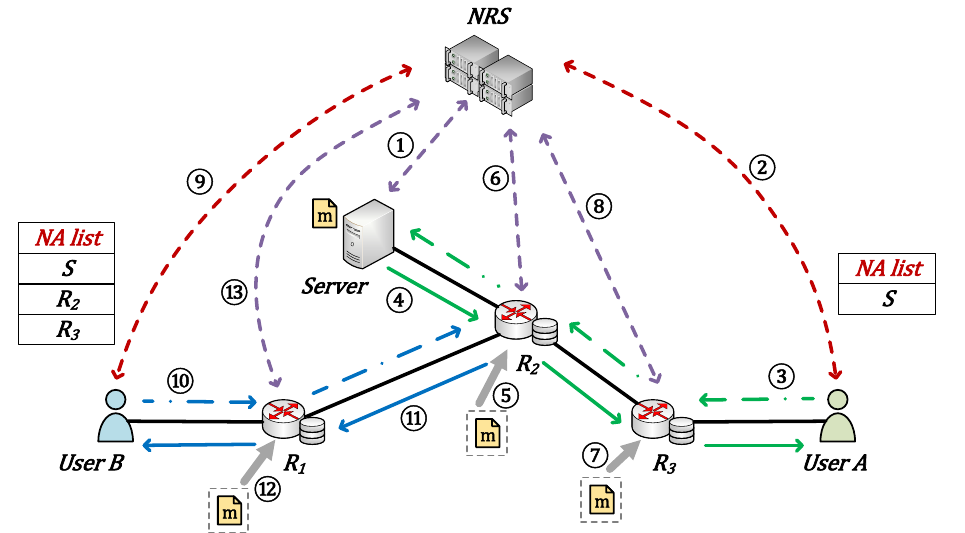
Figure 1. A generic caching scenario in the name resolution-based ICN network.